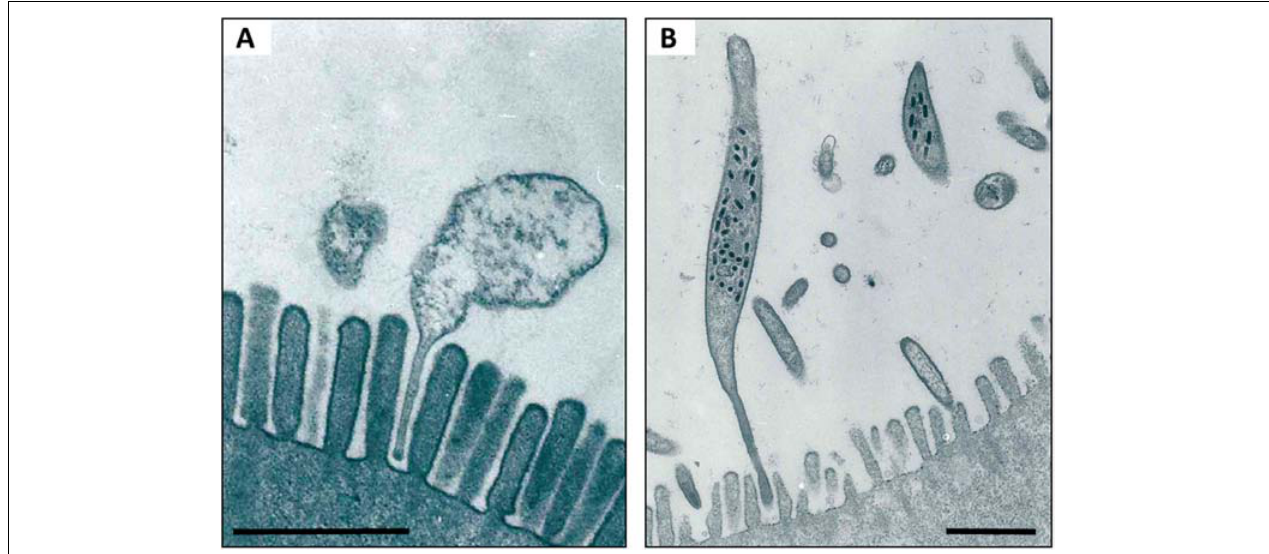
FIGURE 4 | TEM of Hepatoplasma (A) and Hepatincola (B) in the lumen of the hepatopancreas (midgut glands) of P. scaber . Note how both bacteria attach to the microvillous border of the host cell via stalk-like appendages. Scale bars: 1 µ m. Picture credit: Yongjie Wang.